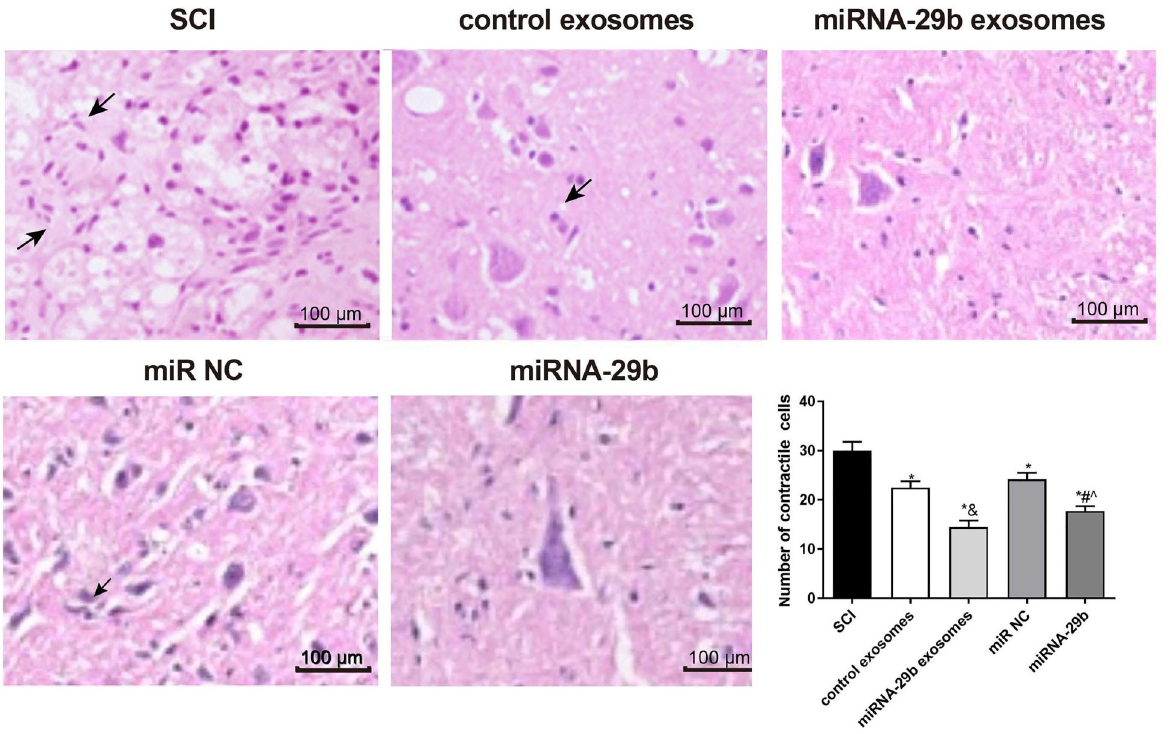
Figure 4. Contractile nerve cells were observed in spinal cord tissues of spinal cord injury (SCI) rats by HE staining at 4 weeks post- injection ( (cid:1) 400, bar=100 m m). Arrows indicate contractile nerve cells. Data are reported as means ± SD. *P o 0.05 vs SCI